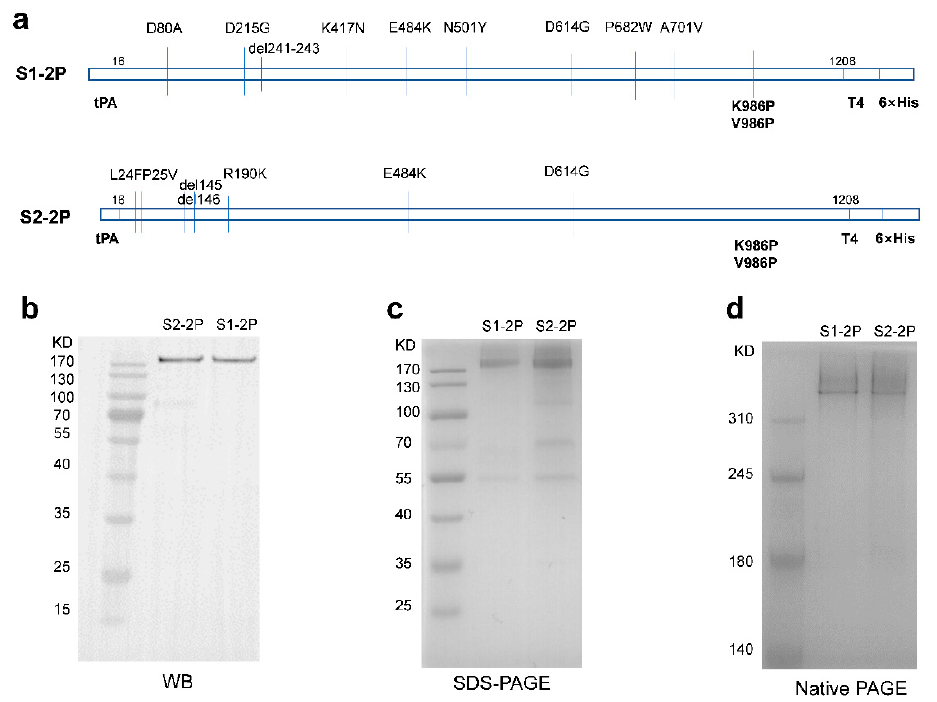
Figure 1. Design, expression, and purification of S-trimer. ( a ) Schematic representations of expression plasmids of SARS-CoV-2 spike protein S1-2P derived from B.1.351 and S2-2P derived from B.1.618. ( b ) WB analysis of purified S protein, HRP-conjugated anti-6 × His antibody used as detection antibody. ( c ) Reducing SDS-PAGE analysis with Coomassie Blue staining of purified S protein. ( d ) Native-PAGE analysis with Coomassie Blue staining of purified S protein.